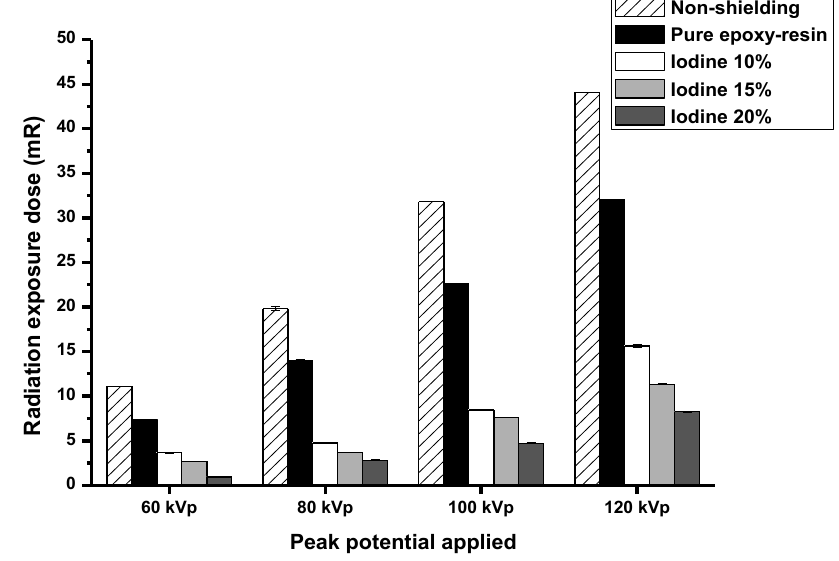
Figure 3. The X-ray dose measurement at different kVp.